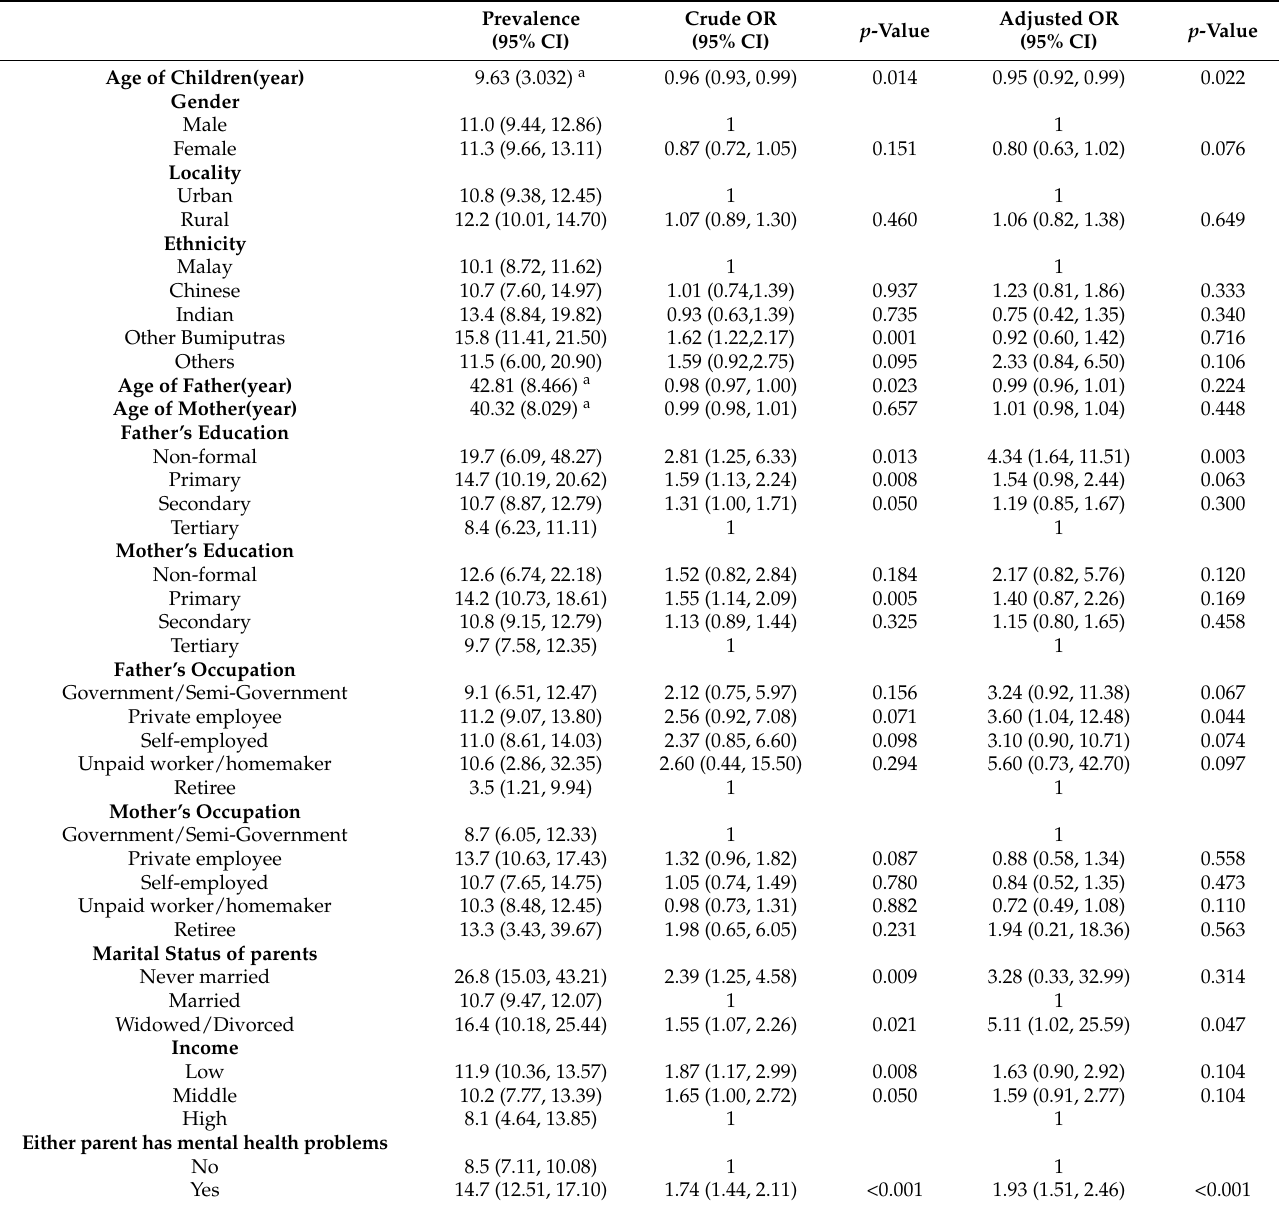
Table 3. Factors associated with mental health problems among children in Malaysia ( n =